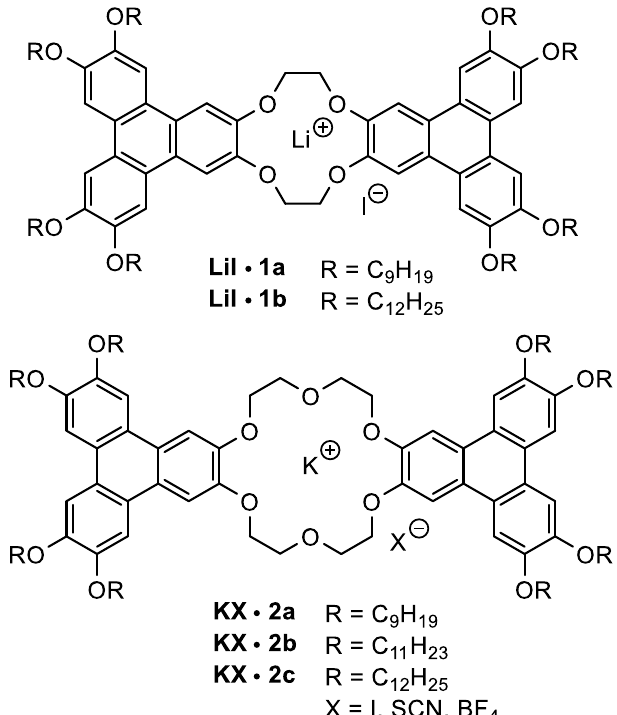
Figure 3. Investigated LiI-complexes of the 12-crown-4 and KX-complexes (X = I, SCN, BF 4 ) of the 18-crown-6 derivative bearing lateral side chains of OC 9 H 19 , OC 11 H 23 , and OC 12 H 25 .